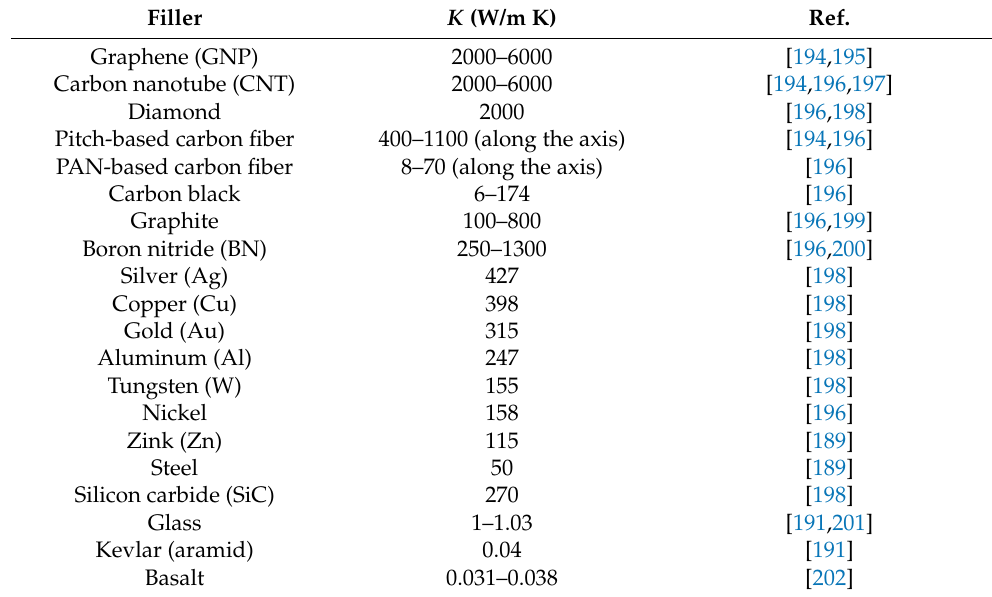
Table 2. Thermal conductivity of commonly used fibers.